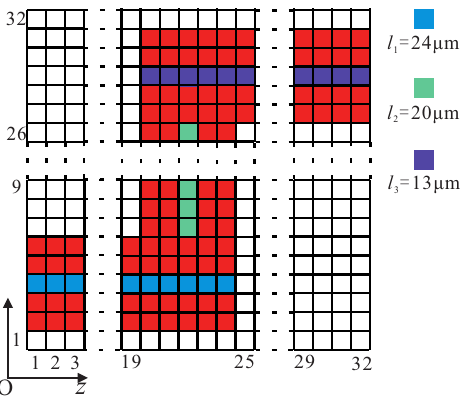
Figure 16. One layer of model four in the direction of y . The diameter of the tube is 5 μ m.